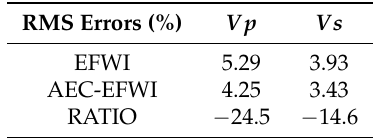
Table 2. RMS errors of the inversion results using AEC-EFWI and elastic full-waveform inversion (EFWI) methods for the Marmousi model